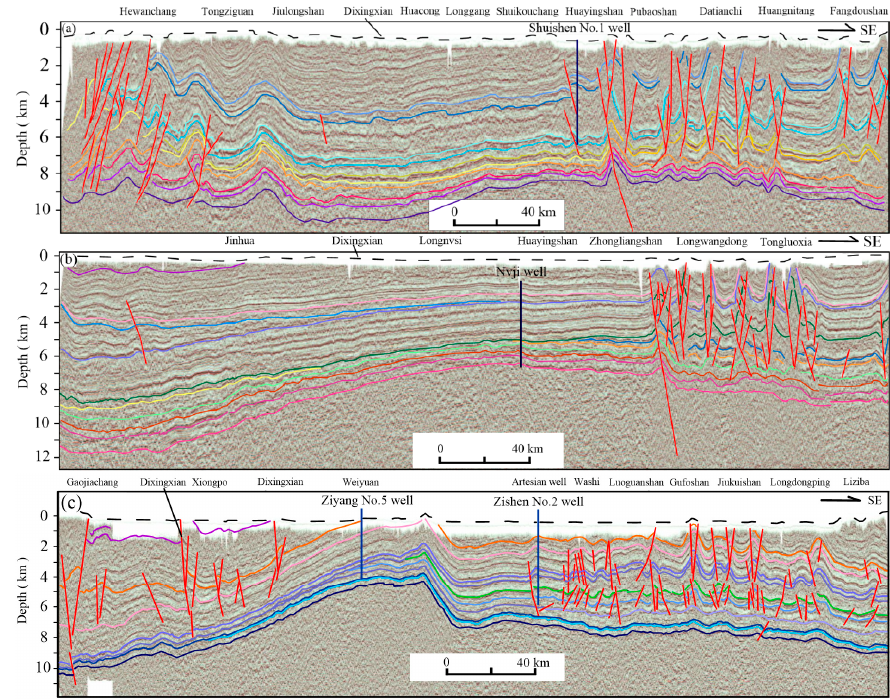
Figure 5. The deep seismic reflection profiles of Sichuan Basin (modified from Li [2]). ( a ) L1; ( b ) L2; ( c ) L3.